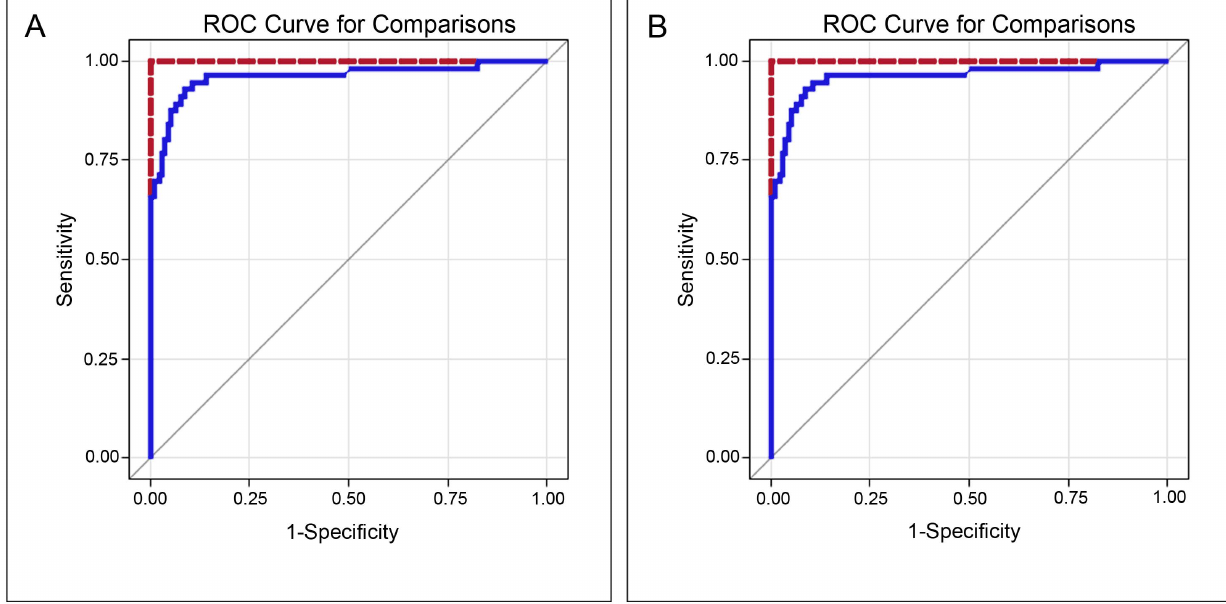
Figure 4. ROC curve analysis for comparison of Glucosylsphingosine. Glucosylsphingosine (A; red line; area under the curve (AUC)=1.00) and Chitotriosidase (A; blue line; AUC=0.96) as well as Glucosylsphingosine (B; red line; AUC=1.00) and CCL18 (B; blue line; AUC=0.86) to discriminate the accuracy of two values. Glucosylsphingosine is significantly more accurate than Chitotriosidase (A: p=0.027, n=228) and CCL18 (B: p , 0.001, n=207).